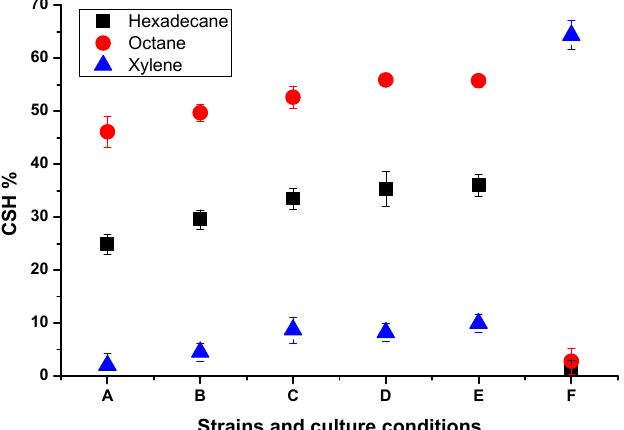
Figure 4. Cell surface hydrophobicity (CSH) of strain BL-27 in different media. Legend meanings: (A: BL-27 in LB medium; B: BL-27 in MSM medium with sucrose; C: the 1st generation of BL-27 in MSM medium with diesel oil; D: the 2nd generation of BL-27 in MSM medium with diesel oil; E: the 3rd generation of BL-27 in MSM medium with diesel oil; F: E. coli BL21 in LB medium.).